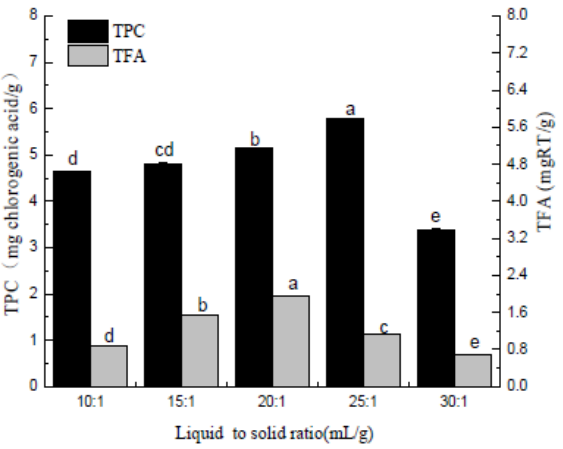
Figure 2. Liquid to solid ratio (mL/g). Three independent experiments were carried out for each analysis. Result is expressed as a mean ± SD ( n = 3). Values with the different letters in the column are significantly different by Duncan’s multiple range test ( p < 0.05).